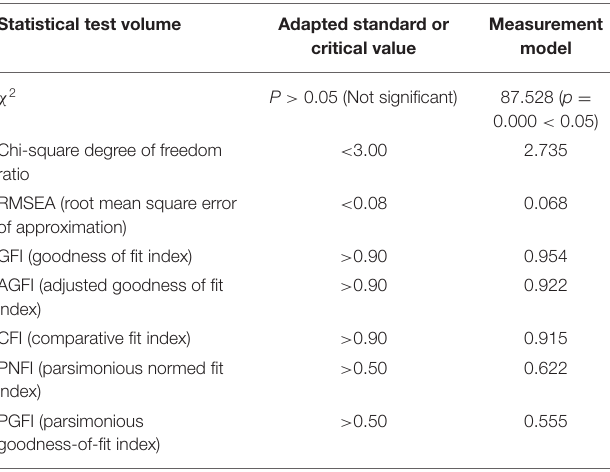
TABLE 7 | Tests on the factors of measurement model